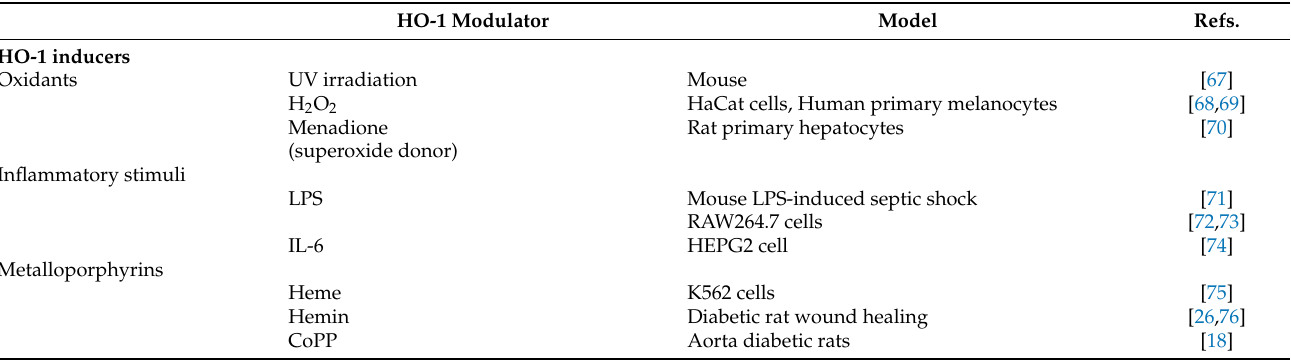
Table 1. Modulators of HO-1 biosynthesis and inhibitors of HO-1 (cid:48) s enzymatic